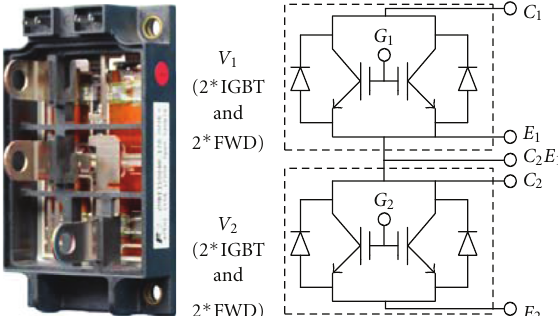
Figure 1: A typical half bridge module and its equivalent circuit.